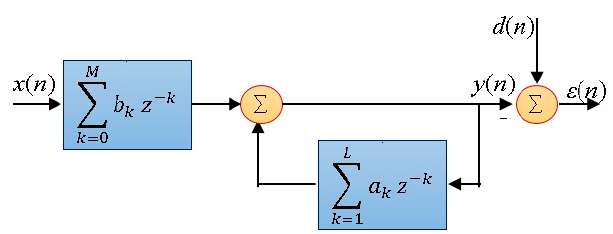
Figure 2. Recursive adaptive infinite impulse response (IIR).